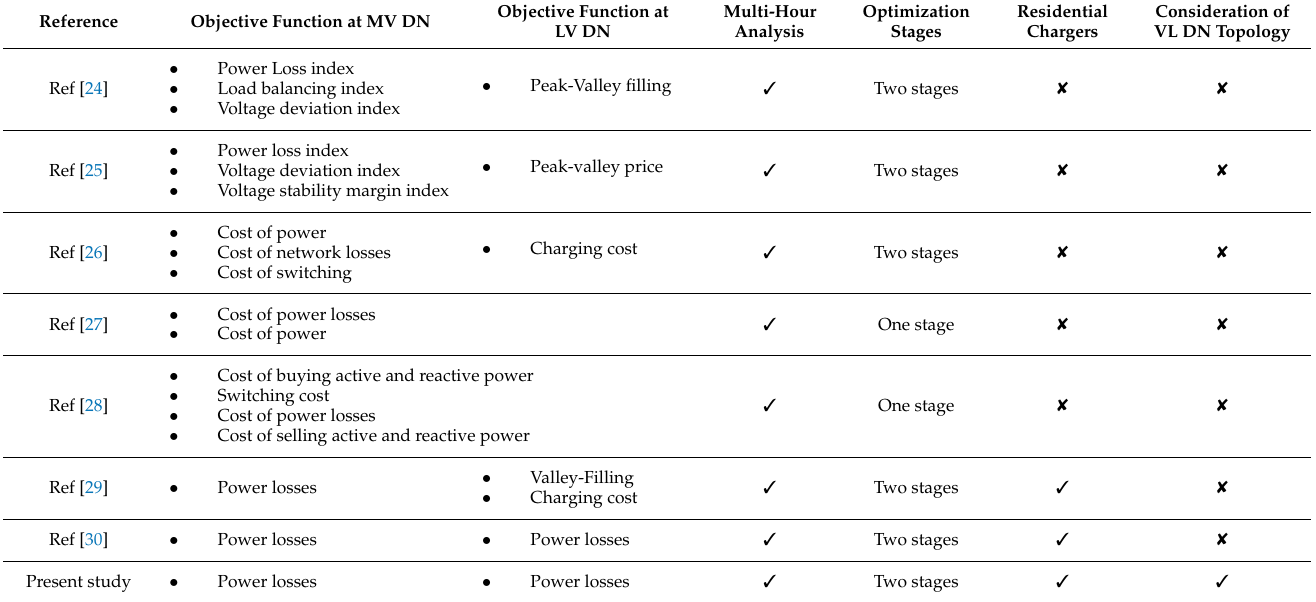
Table 1. Literature review of the methodologies NR and optimal charging